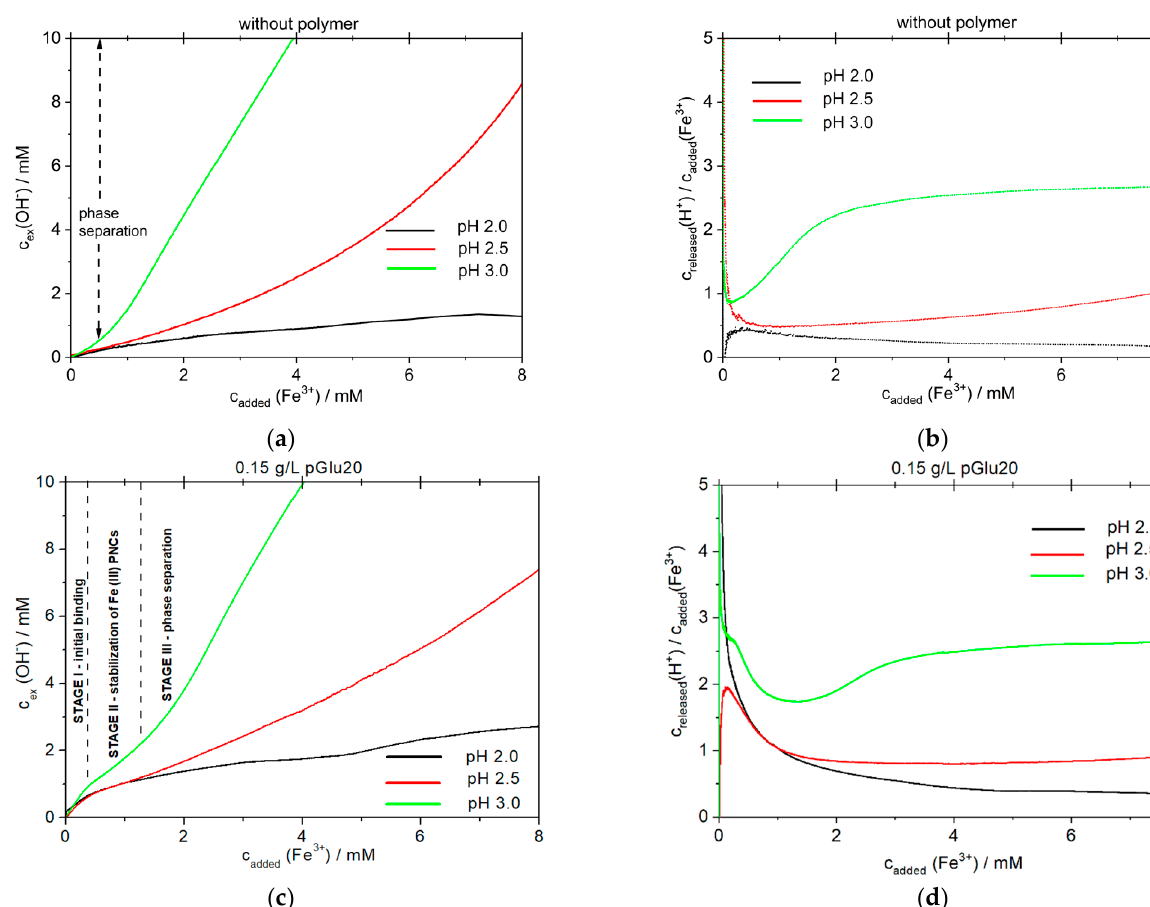
Figure 1. Titration curves of the Fe(III) system: ( a ) without polymer and ( b ) the corresponding c released (H + )/c added (Fe 3+ ) ratio vs. c added (Fe 3+ ) curves; ( c ) 0.15 g/L pGlu20 and ( d ) the corresponding c released (H + )/c added (Fe 3+ ) ratio vs. c added (Fe 3+ ) curves.